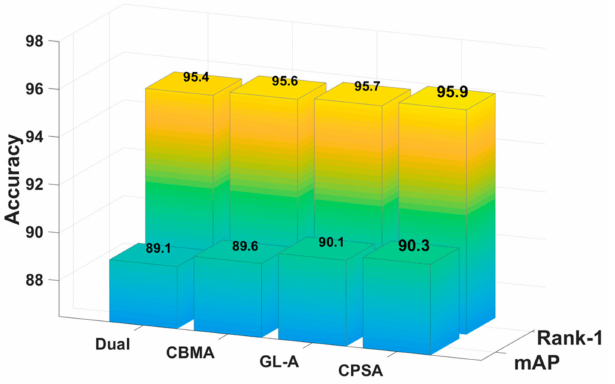
Figure 10. The comparative experiments of CPS-Attention on Market-1501.